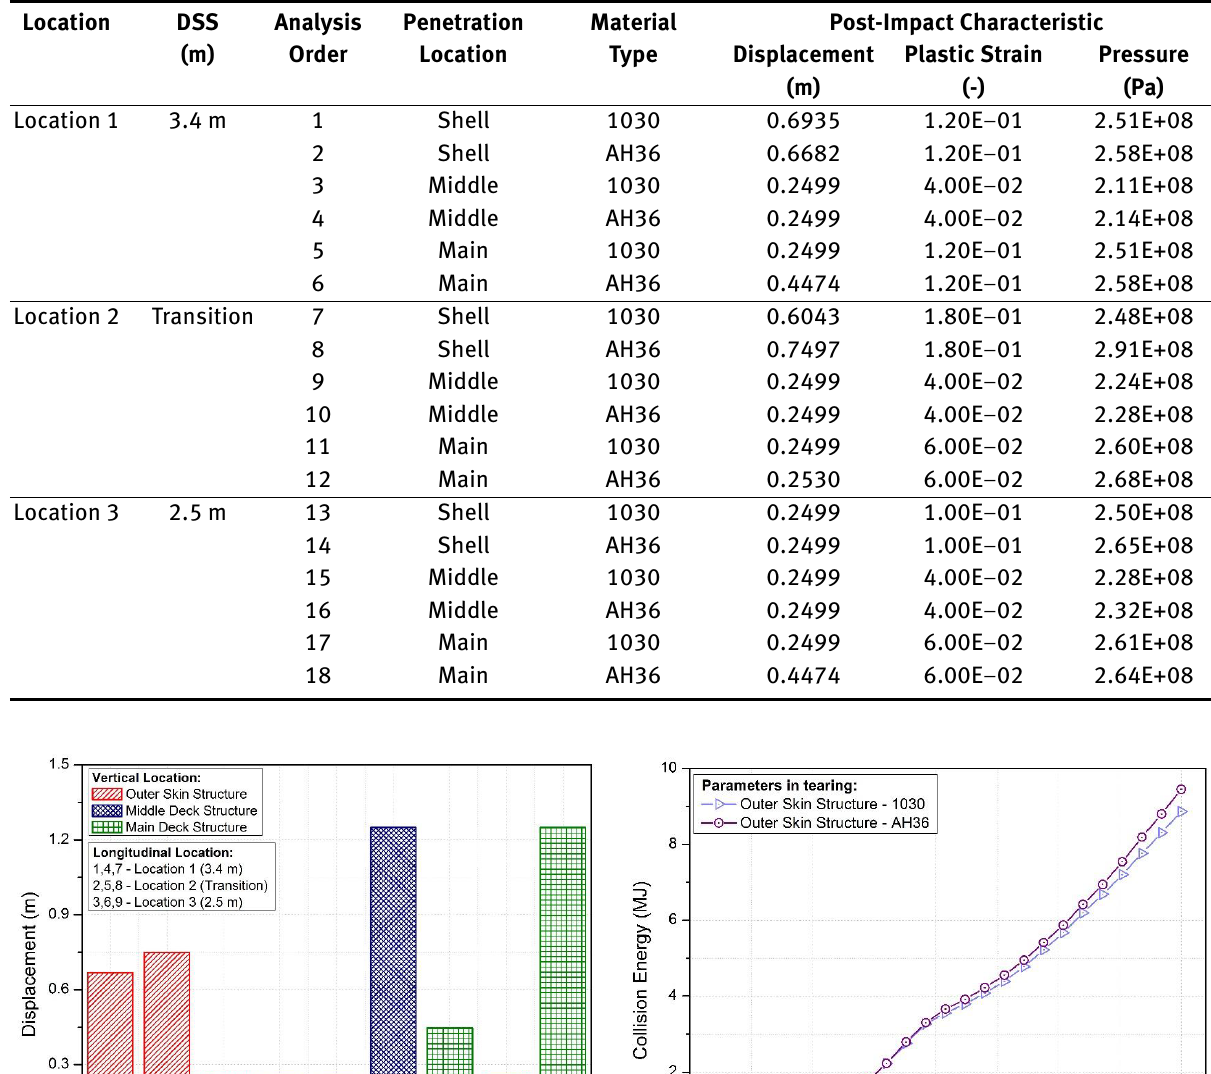
Table 7: Detail of inner skin after experienced impacts.